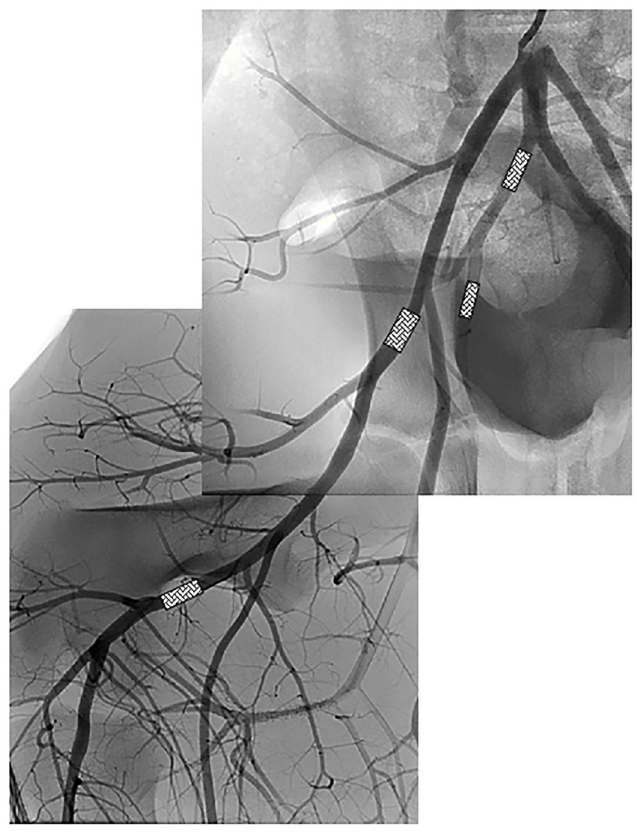
Fig 2. Location of stent implantation in vessel segments of femoral and internal iliac arteries. Two stents (depicted here as box) per artery were implanted—one each in the proximal and distal vessel segment. Dimensions of the stents are described in the Materials and methods section.